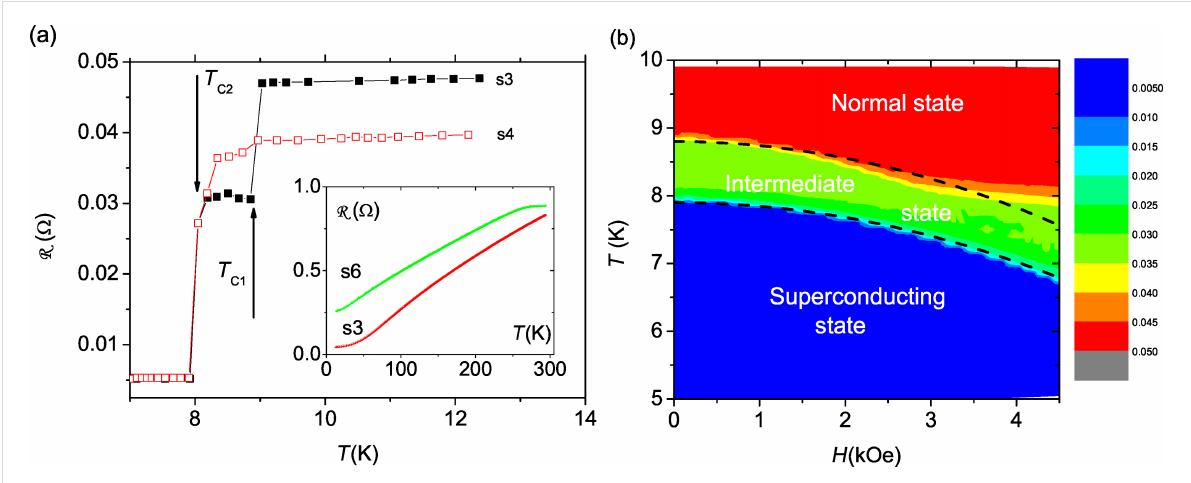
Figure 6: (a) ( T ) for the samples s4 (black) and s3 (red) in the vicinity of the superconducting transition measured in zero magnetic field. The inset shows the resistance of samples s3 and s6 between room temperature and 10 K in H = 4.5 kOe. (b) The H – T dependence of resistance of the sam- ple s3. The color bar depicts resistance in ohms. The bottom dashed line show the dependence T c 2 ( H ) = T c 2 (0) [1 − ( H / H c 2 (0)) 2 ] with H c 2 (0) = 12 kOe. The upper dashed line is shifted 0.9 K up from the bottom one to show borders of the intermediate state.